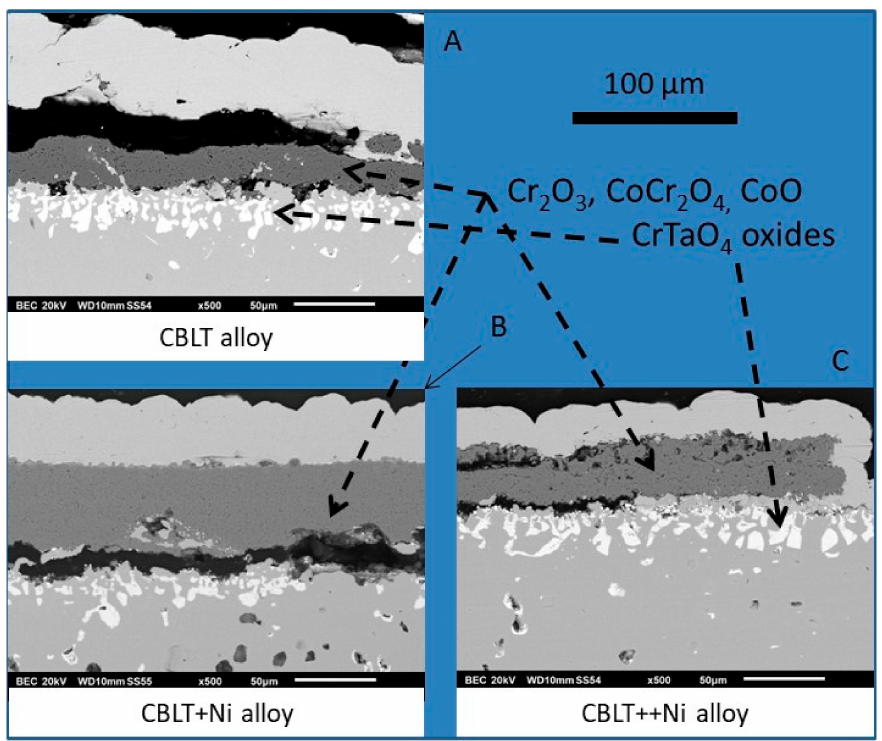
Figure 9. Detailed view of the surfaces and subsurfaces affected by oxidation: ( A ): the CBLT alloy; ( B ): the CBLT+Ni’ alloy; ( C ): the CBLT++Ni